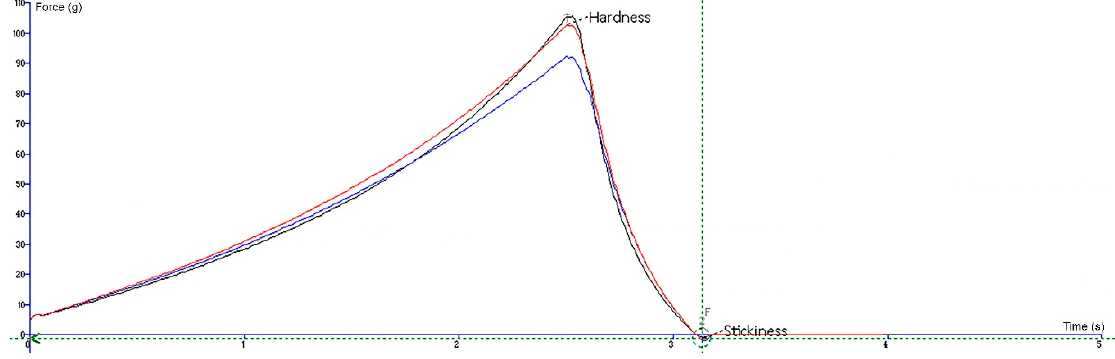
Figure 6. A graphical view of the penetration test. The lines represent the three replicates of the sample.